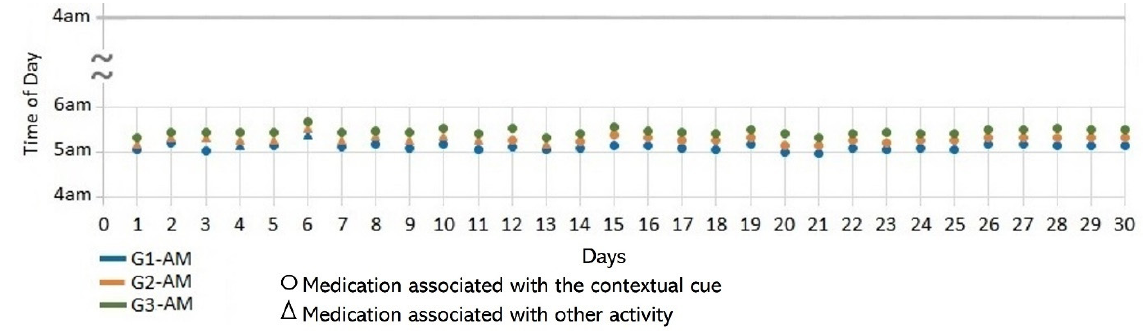
Figure 8. The days that S3 performed their medication episodes (G1-AM, G2&G3-AM, and G3-PM) after and before the reported activities.